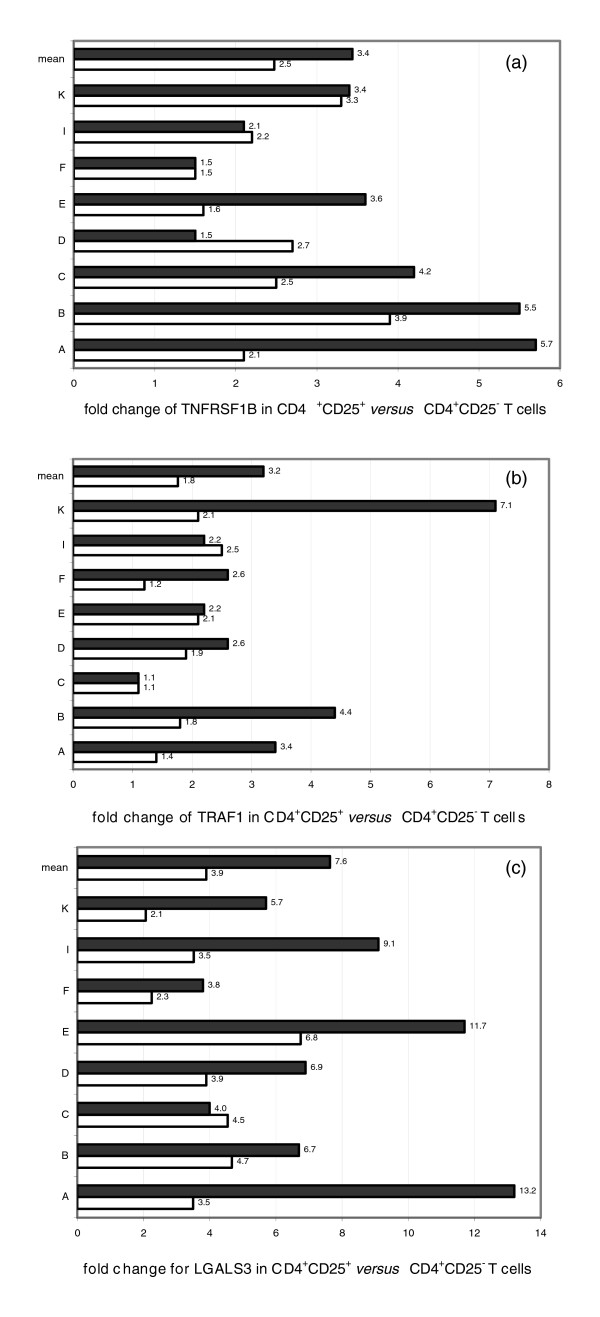
New players: confirmation of microarray results. Real-time RT-PCR was performed for (a) TNFRSF1B, (b) TRAF1, and (c) LGALS3 expression in MACS isolated human CD4+CD25+ TReg and CD4+CD25- naïve T cells. Fold changes were calculated as described for Figure 4. Real-time RT-PCR results (black bars) were compared with fold changes arising from the Human TReg Chip (white bars). The healthy donors are specified by letters (see Table 1). RT-PCR, reverse transcription polymerase chain reaction.